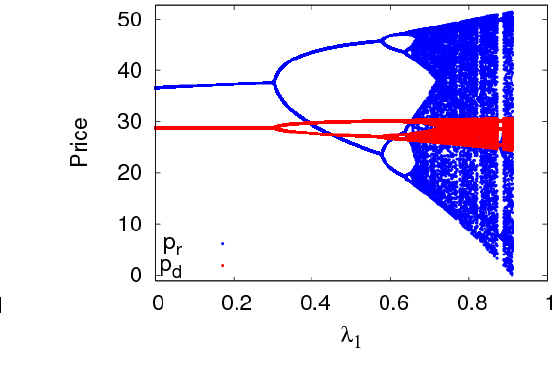
Figure 8. The parameter basins of dynamic System (7) in the planes of (𝛼 1 , 𝜌) and (𝛼 2 ,𝜌).